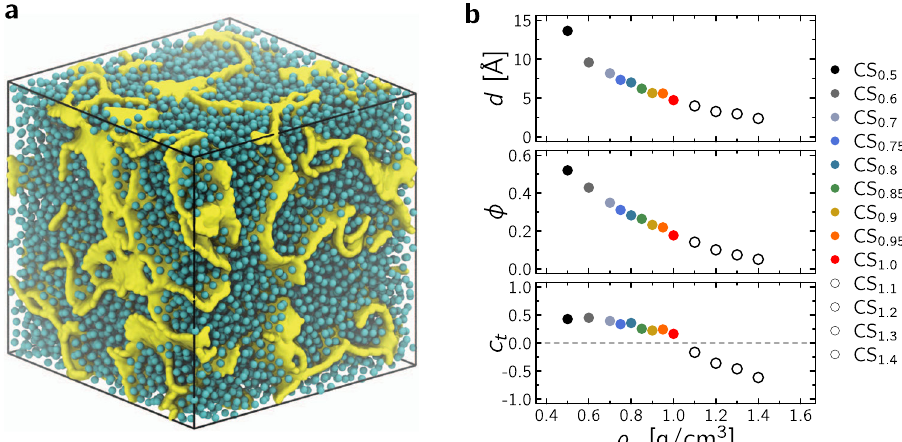
Fig. 1 Prototypical disordered nanoporous structures. a Molecular con fi guration for methane in a disordered nanoporous carbon (here CS 0.70 , box length 100 Å ). The cyan spheres are methane molecules while the yellow surface represents the carbon porous network. b Mean pore diameter d (top), porosity ϕ (middle), and connection number c ρ t (bottom) as a function of structure density s of the digitized pore networks. The same color code applies throughout the manuscript. The samples obtained at larger densities — shown as white/open circles — possess unconnected porous networks ( c t < 0) so that no diffusion is observed in the long time